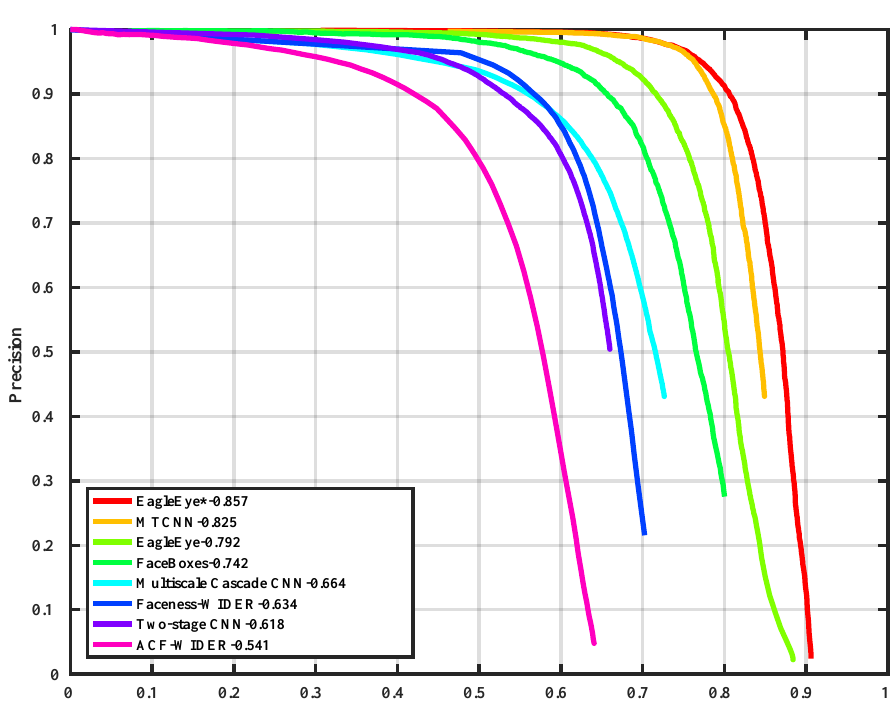
Figure 7. Precision-recall curve on wider face validation (medium)